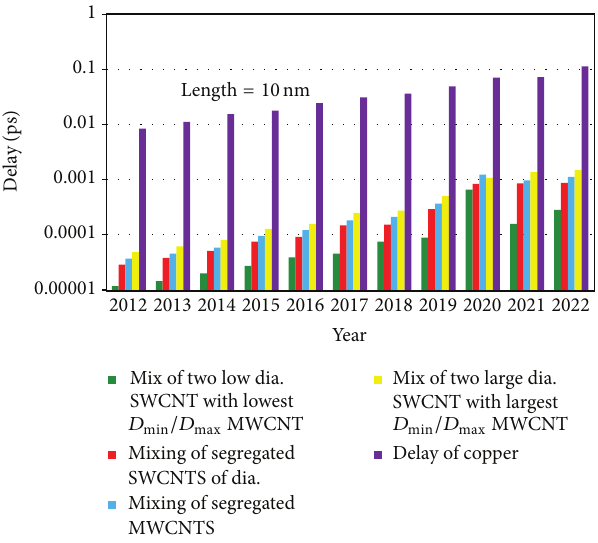
Figure 4: Propagation delay of mixed CNT bundle versus segre- gated bundle at local level.